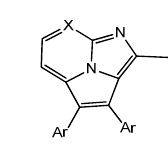
Table 16. Substituents and yields of reaction of 2-arylimidazopiridines and diarylacetylenes (Scheme